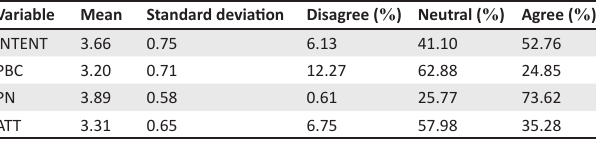
TABLE 2: Descriptive statistics of the results. Variable